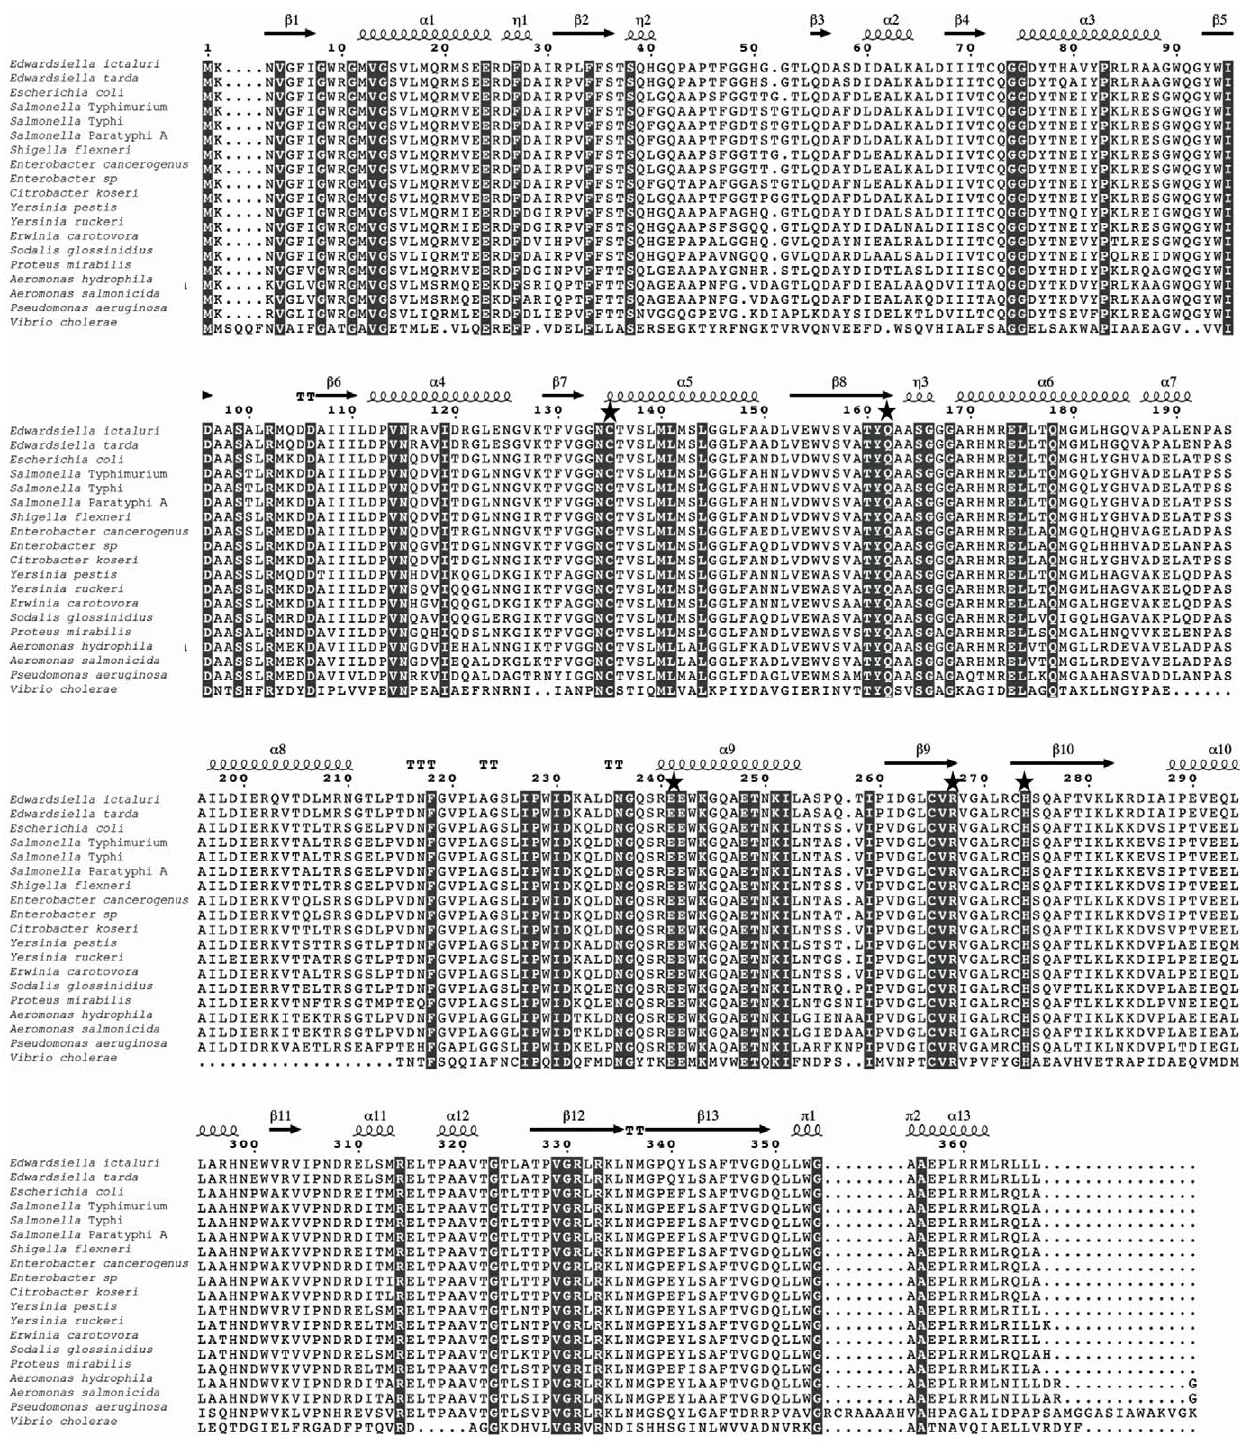
Figure 1. Sequence alignment among representative members of the AsdA family. The secondary structure at the top of the alignment corresponds to the E. ictaluri AsdA enzyme (spirals represent a -helix; arrows represent b -sheet). Conserved amino acids residues are indicated in grey. The stars indicated the key catalytic active site residues (Cys-135, Gln-162, Glu-241, Arg-267, and His-274). The AsdA sequences were obtained from NCBI’s Entrez Protein database for Edwardsiella ictaluri YP_002935083.1; Edwardsiella tarda YP_003297386.1; Escherichia coli AP_004358.1; Salmonella Typhi NP_807591.1; Salmonella Paratyphi A YP_152515.1; Salmonella Typhimurium AAB69392.1; Shigella flexnieri YP_690789.1; Shigella sonnei YP_312455.1; Citrobacter koseri YP_001456333.1; Enterobacter cancerogenus ZP_05969786.1; Enterobacter sp. YP_001178547.1; Yersinia pestis NP_671174.1; Yersinia ruckeri ZP_04615435.1; Proteus mirabilis YP_002152826.1; Aeromonas hydrophila ABK39477.1; Aeromonas salmonicida YP_001142146.1; Sodalis glossinidius YP_456010.1; Vibrio cholerae YP_001217562.1; Pseudomonas aeruginosa NP_251807.1; Erwinia carovora atrosepticum YP_052242.1.